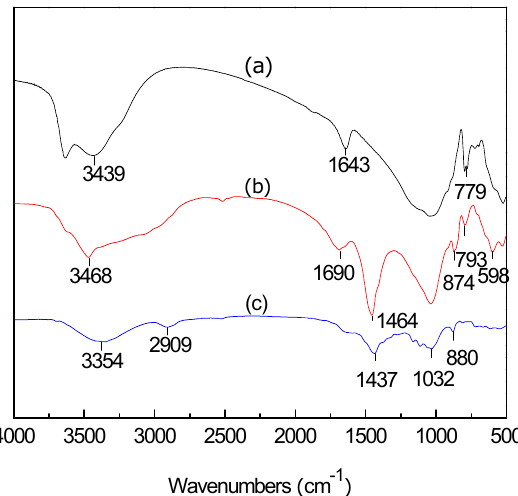
Figure 1. Fourier Transform Infrared Spectroscopy (FTIR) spectra of: ( a ) purified montmorillonite (MT); ( b ) lignocellulose/montmorillonite (LMT); and ( c ) lignocellulose (LC).